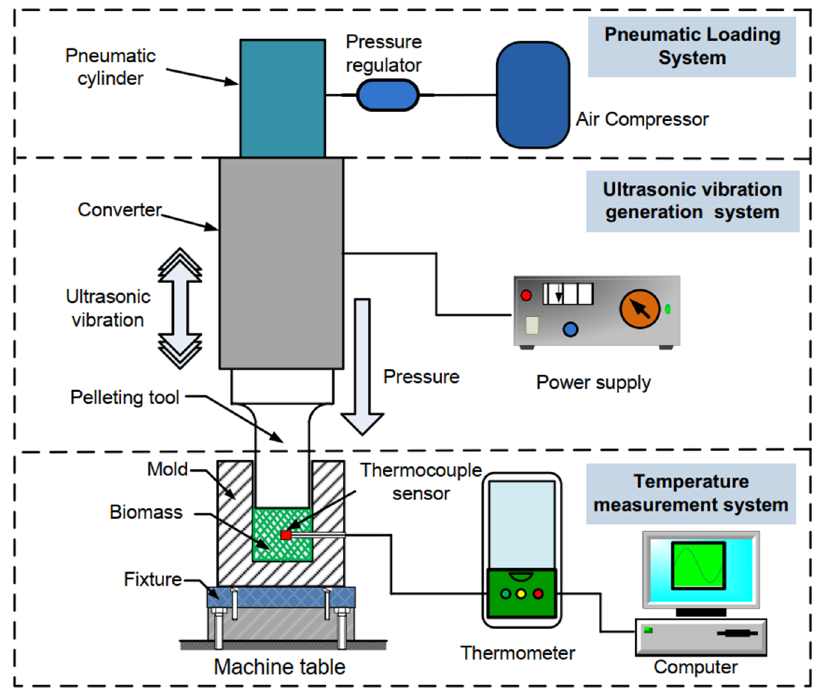
Figure 6. Schematic illustration of the ultrasonic pelleting unit. Adapted with permission from Ref. [41]. 2016,